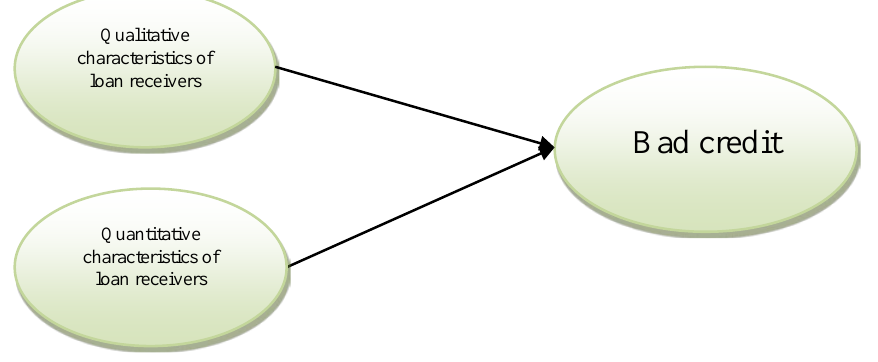
Fig. 1. The structure of the proposed